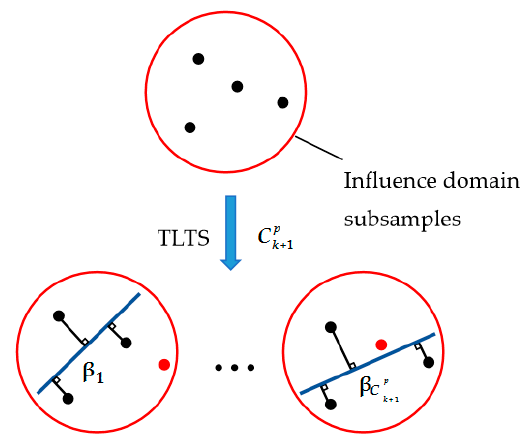
Figure 3. Schematic graph of the Moving Total Least Trimmed Squares (MTLTS) method.